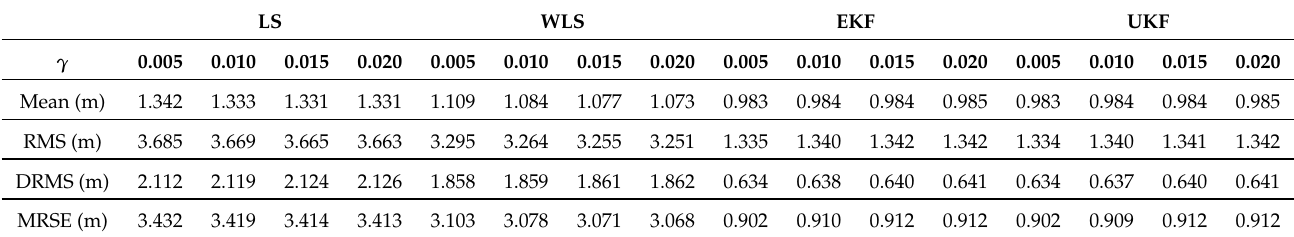
Table 1. Error metrics for different values of γ of the Hatch Filter for the ESA Malargüe receiver. LS WLS EKF UKF γ